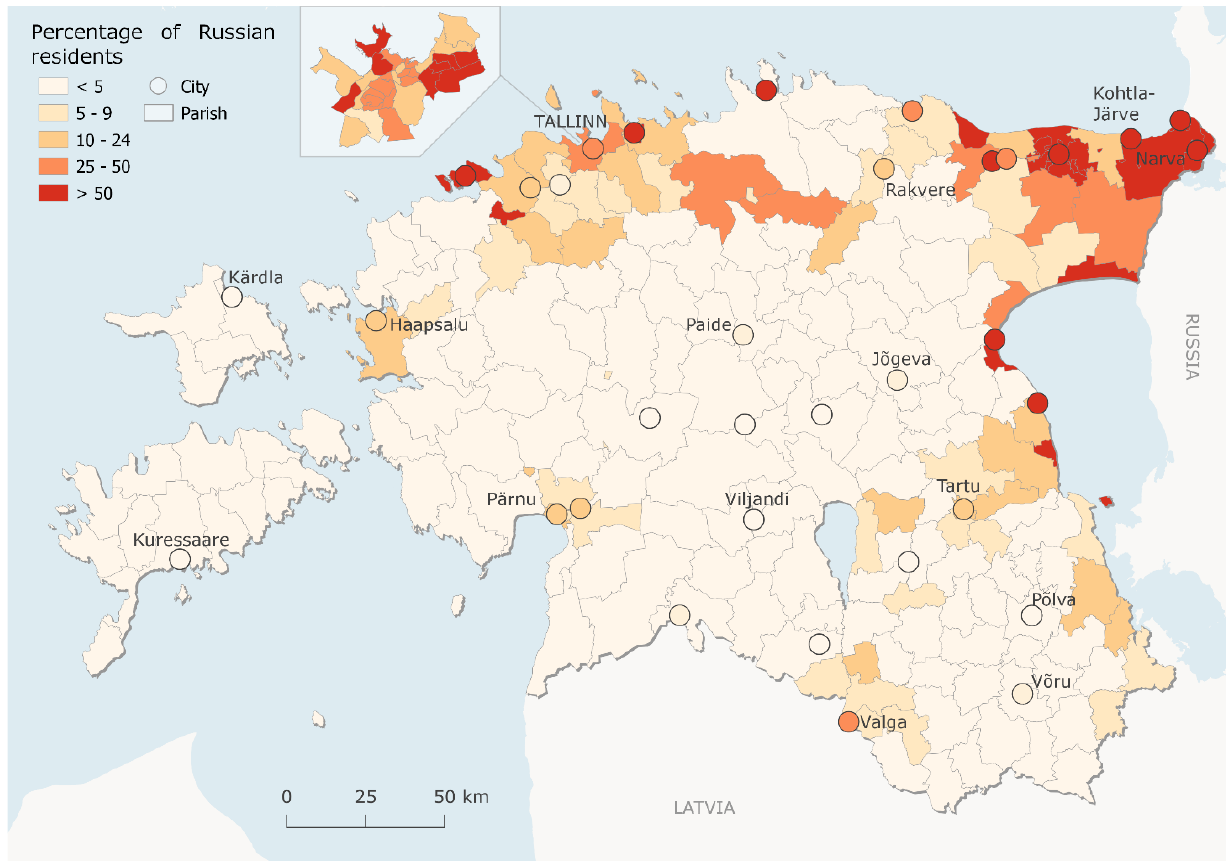
Figure 2. Distribution of the Russian-speaking minority population in Tallinn and Estonia according to the 2011 census (Statistics Estonia,